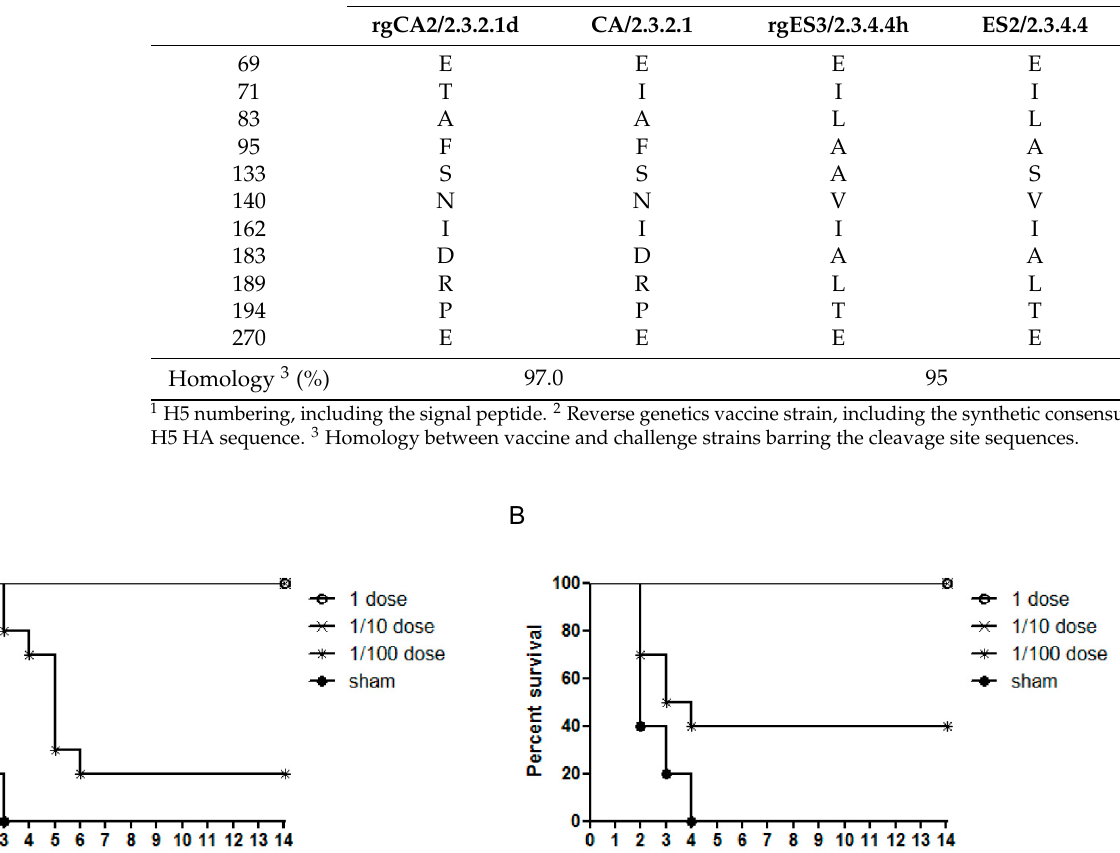
Table 2. Comparison of variable amino acid sequences related to vaccine protection. Figure 1. Phylogenetic trees of clades 2.3.2.1 and 2.3.4.4 (HA; H5). The vaccine strains developed by reverse genetics are indicated in red. Each tree was built using the distance-based neighbor-joining method in MEGA6 software (bootstrap value = 1000). Red boxes indicate challenge strain and blue boxes indicate vaccine strain. ( A ) rgCA2/2.3.2.1d. ( B ) rgES3/2.3.4.4h.